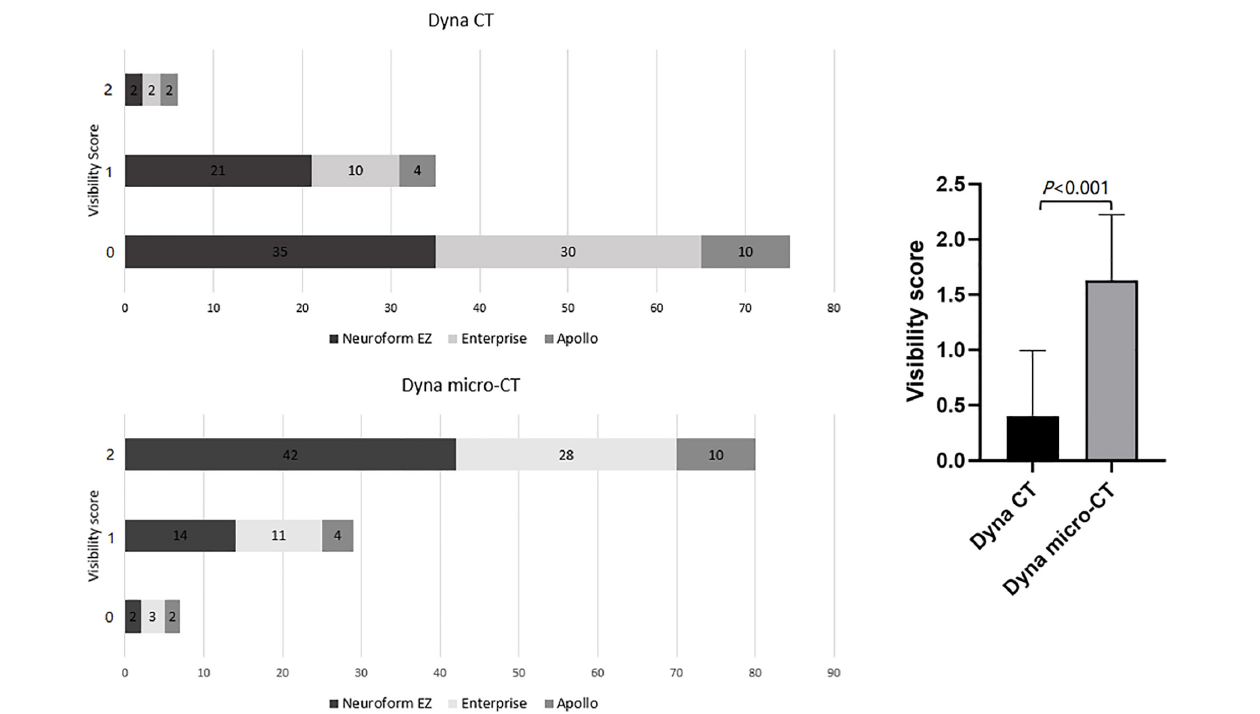
FIGURE 2 | Comparison of the stent visibility scores using FDCT and HR-FDCT (Neuroform EZ stent, n = 58; Enterprise stent, n = 42; Apollo stent, n =